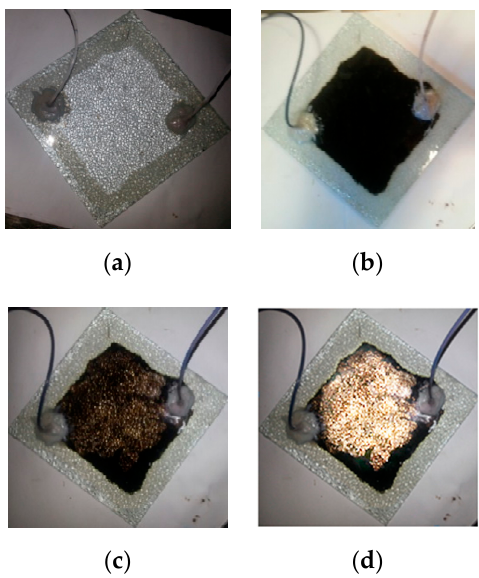
Figure 12. Oil displacement experiments by surfactants: ( a ) after saturating with formation water, ( b ) after saturating with heavy crude oil, ( c ) after petroleum sulfonate flooding, ( d ) after SDY-1 flooding.